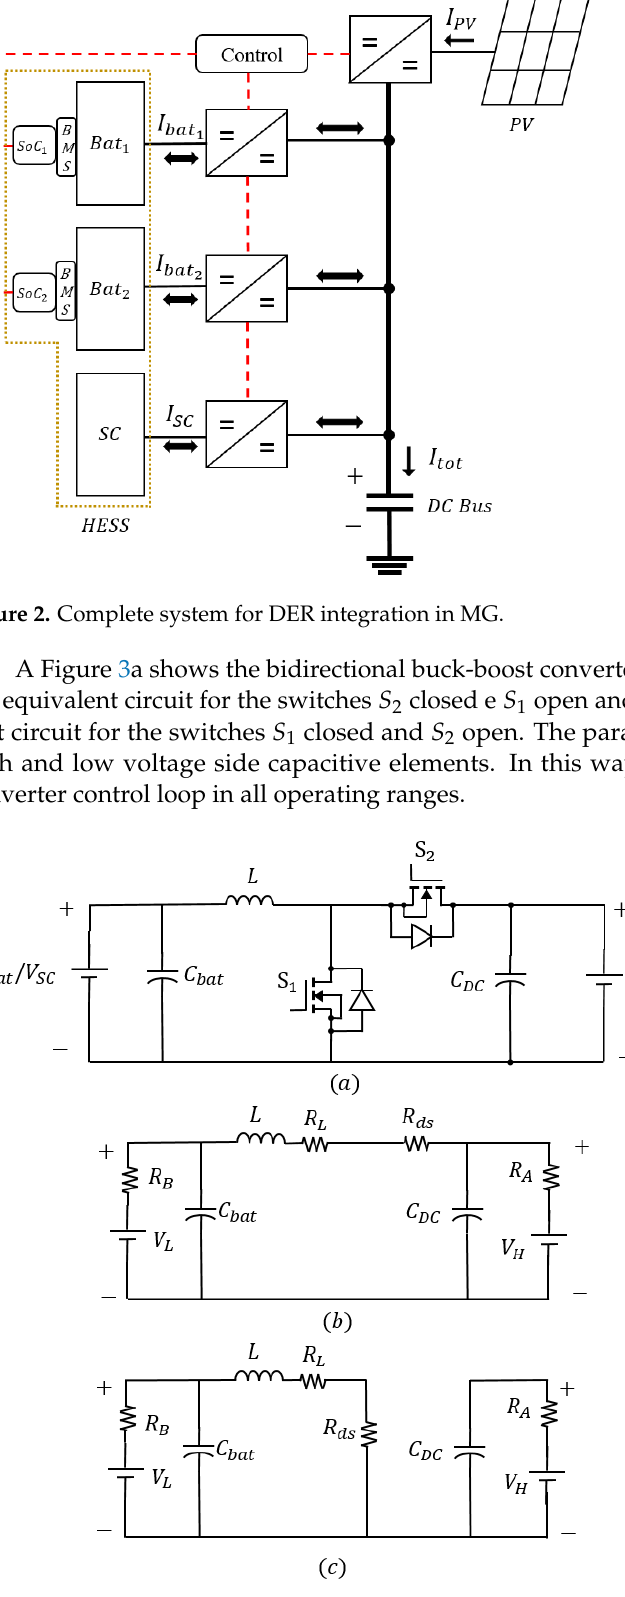
Figure 3. ( a ) Buck-boost Bidirectional converter; ( b ) equivalent circuit S 1 open and S 2 close; ( c ) equiv- alent circuit S 2 open and S 1